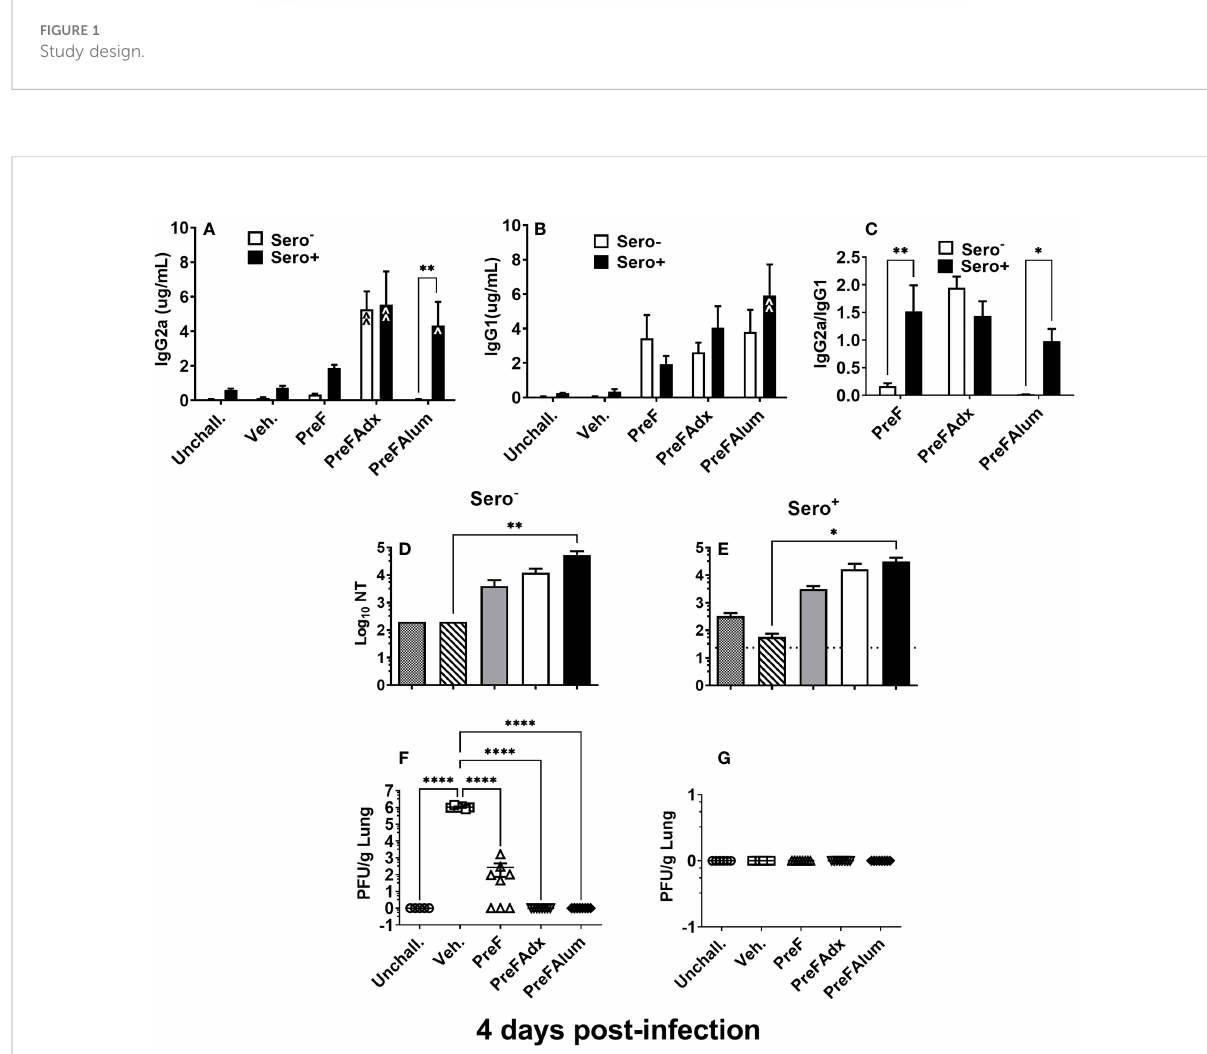
FIGURE 2 Prior RSV exposure increases the IgG2a/IgG1 ratio in immunized mice. Sero- and sero+ mice were immunized and challenged with RSV as described in Figure 1. RSV-speci fi c IgG2a (A) , IgG1 (B) , the IgG2a/IgG1 ratio (C) , and Log10 NTs (D, E) were determined from pre-challenge serum collected immediately prior to RSV challenge. At 4 dpi, dams were culled, and tissues collected for analysis. Left lungs were harvested and processed for viral quanti fi cation using H&E plaque assays (F, G) . Viral titers were performed in triplicate and data within each group represent the mean titer for each animal. Lungs with no detectable virus were considered sterile. Data are represented as mean ± SEM of two independent experiments ( n = 8 mice). Statistical signi fi cance was determined between sero- and sero+ groups within each immunization cohort using 2-way ANOVA with a Bonferroni post-test; *p<0.05, **p<0.01. Nonlinear regression was used to obtain IC50 values (D, E) and comparisons to Veh controls within the respective sero- and sero+ groups were made using an ANOVA with a Dunnett ’ s multiple comparison test; (A, B) ^p<0.05, ^^p<0.01 and (D – G) *p<0.05, **p<0.01, ****p<0.0001.